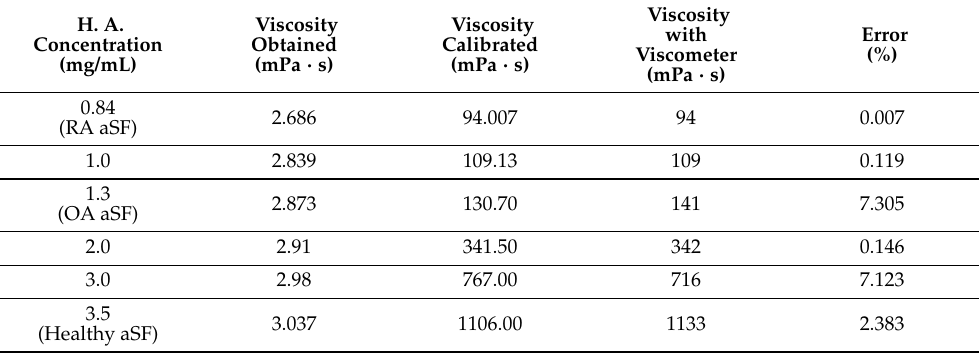
Table 7. Resulting viscosity after calibration for